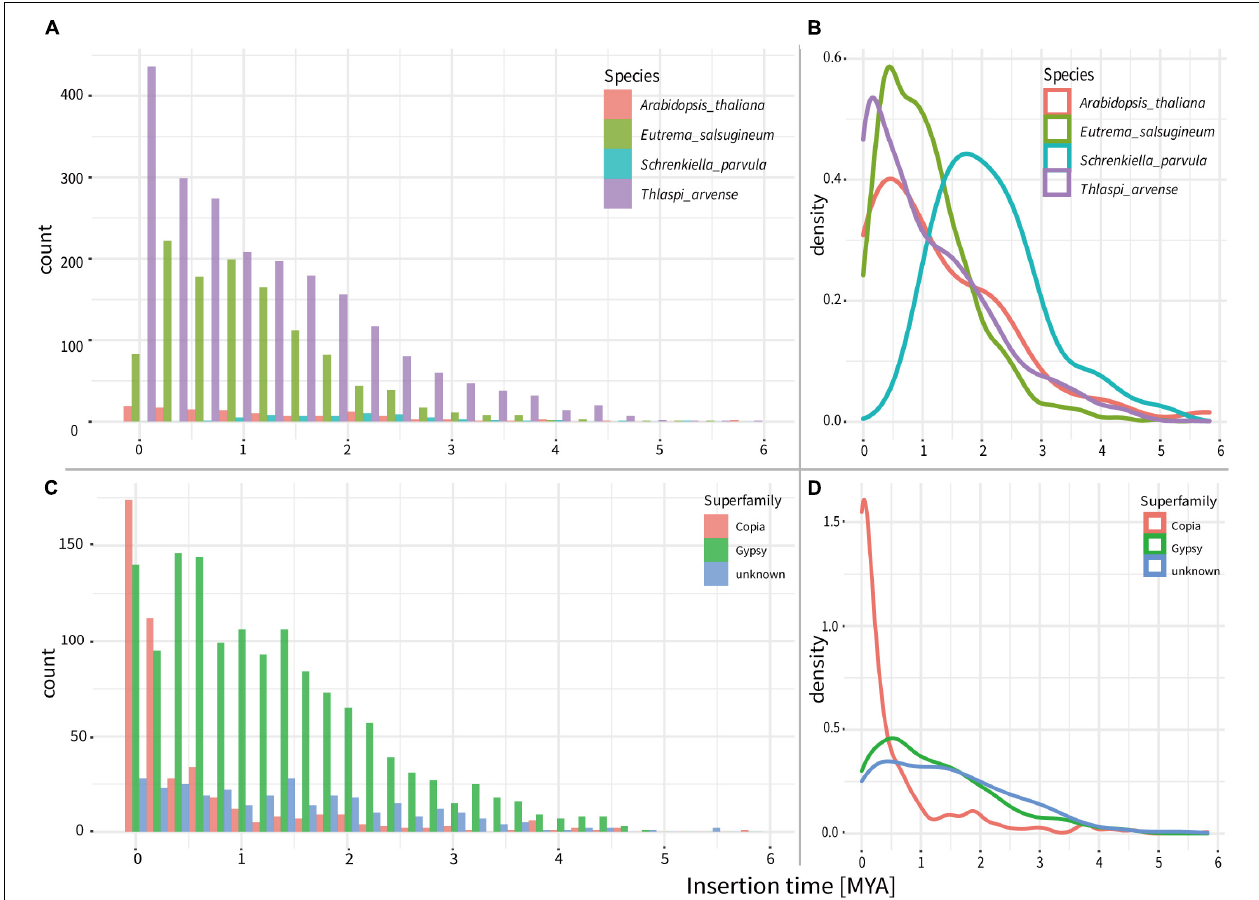
FIGURE 3 | Ages of intact LTR-RTs in the genomes of T. arvense and other three close relatives of Brassicaceae. (A) Counts of all LTR-RTs ages in the T. arvense and other three close relatives. (B) Density lines of all LTR-RTs ages in the T. arvense and other three close relatives. (C) Counts of ages of different LTR-RT superfamilies in the T. arvense . (D) Density lines of ages of different LTR-RT superfamily in the T. arvense